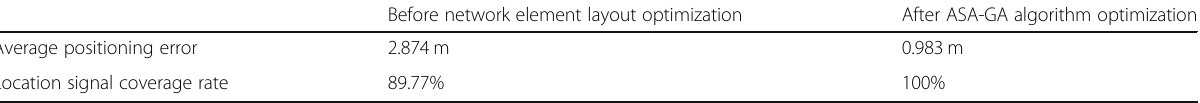
Table 2 Changes before and after optimization of network element layout